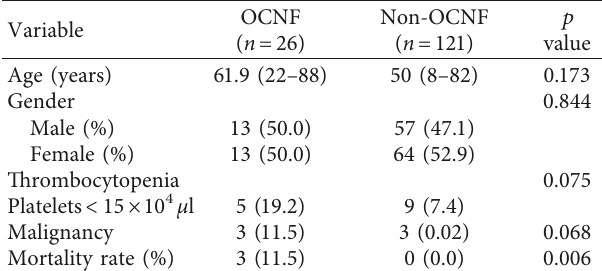
Table 1: Patient background in the OCNF and non-OCNF